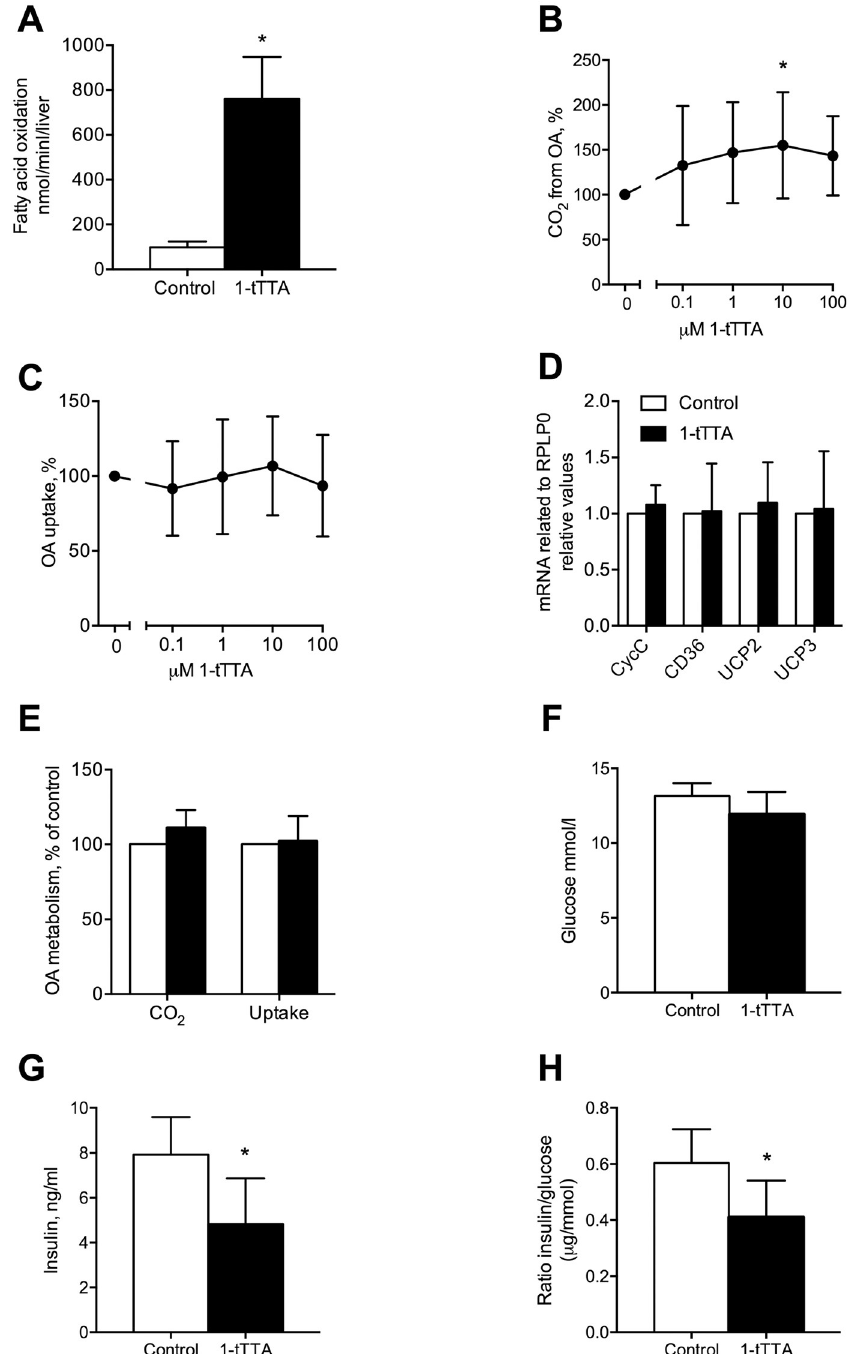
Fig 2. Effects 1-triple TTA (1-tTTA) on fatty acid metabolism and plasma insulin and glucose levels both in vivo and in vitro. ( a ) Rats were treated with vehicle (control) or 100 mg/kg body weight 1-tTTA for 3 weeks and palmitoyl- CoA oxidation in liver was measured (n = 5–8). ( b ) Oleic acid oxidation and ( c ) oleic acid uptake, measured as described in Materials and Methods, in human Huh7 liver cells treated with vehicle (control) or 1-triple-TTA for 48 h (n = 6–8). ( d ) Gene expression of cytochrome c-1 ( CycC ), CD36 molecule ( CD36 ), uncoupling protein ( UCP ) 2 and UCP3 in Huh7 cells treated with 10 μ M 1-tTTA for 48 h (n = 6–8). ( e ) Oleic acid oxidation and uptake in human myotubes treated with 10 μ M 1-tTTA for 96 h (n = 4). ( f ) Plasma glucose, ( g ) insulin, and ( h ) insulin/glucose ratio in rats treated with vehicle (control) or 1-tTTA for 3 weeks (n = 5–8). Values shown are means with standard deviation. Statistically significant differences between means were determined using Students t-test, � p < 0.05 vs. control.